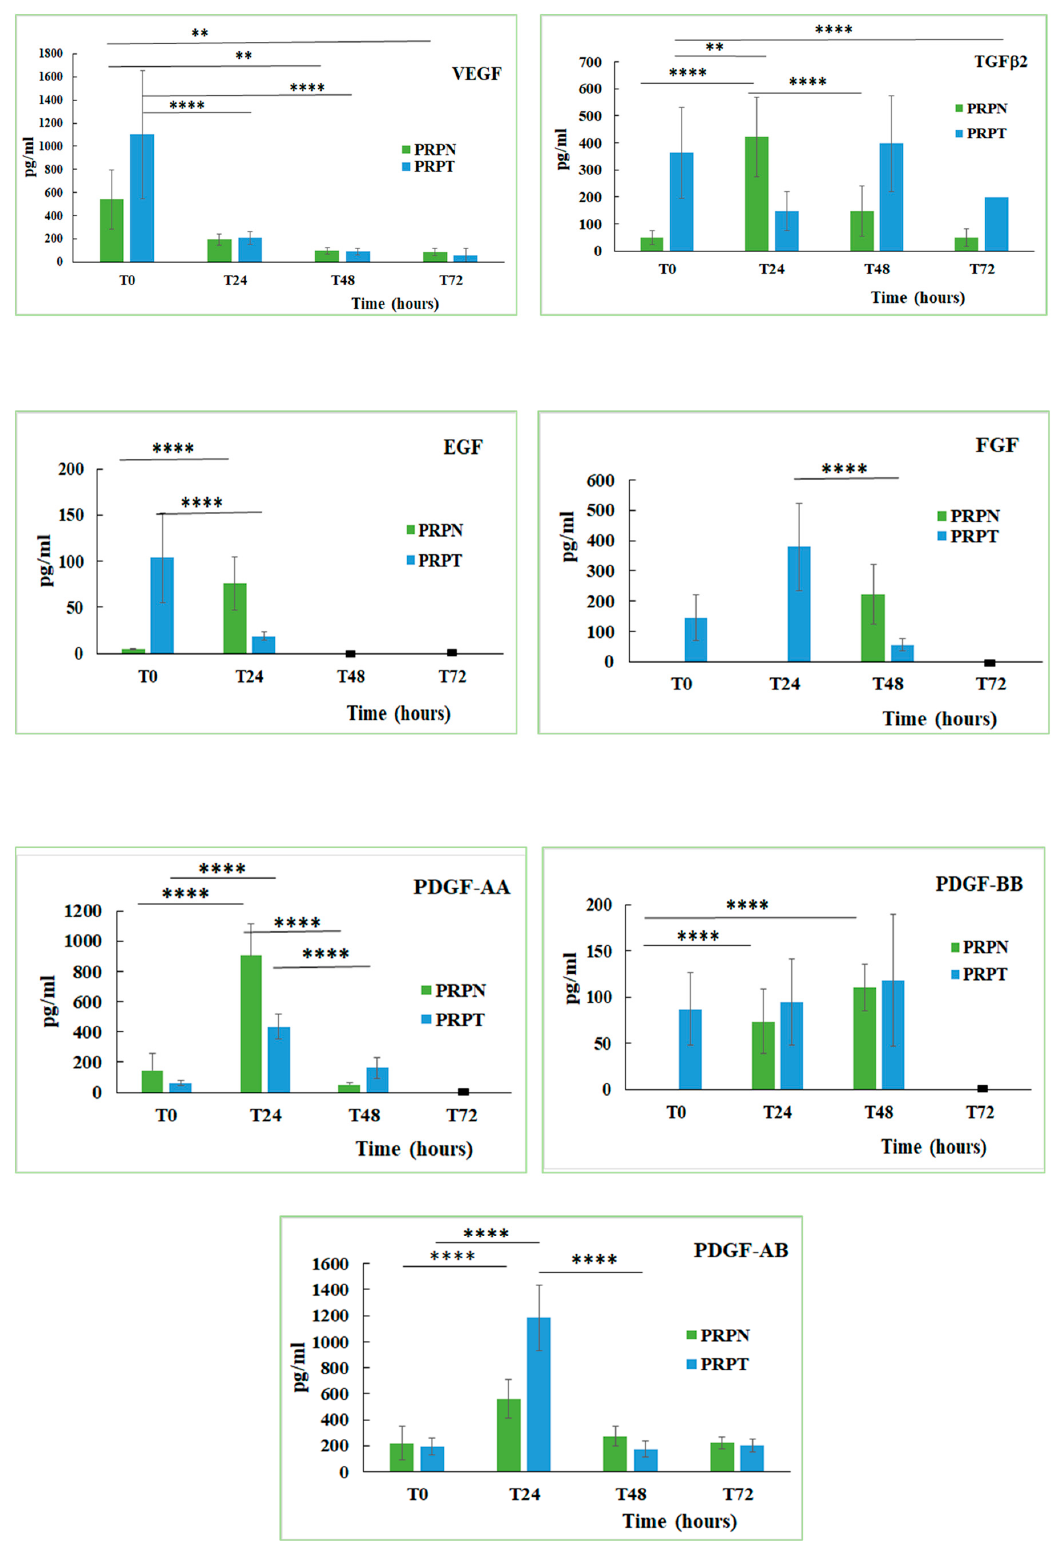
Figure 6. Concentration (pg / mL) of growth factors (Vascular Endothelial Growth Factor, VEGF; Transforming Growth Factor β 2, TGF β 2; Endothelial Growth Factor, EGF; Fibroblast Growth Factor, FGF; Platelet-derived Growth Factor-AA, PDGF-AA; Platelet-derived Growth Factor-BB, PDGF-BB; Platelet-derived Growth Factor-AB, PDGF-AB) in PRP activated (PRPT) or not activated (PRPN) with autologous thrombin-rich solution at T0 and after incubation at 37 ◦ C for 24 h (T24), 48 h (T48) and 72 h (T72). ** P < 0.01; **** P < 0.0001. ( (cid:4) ): value lower than the limit of